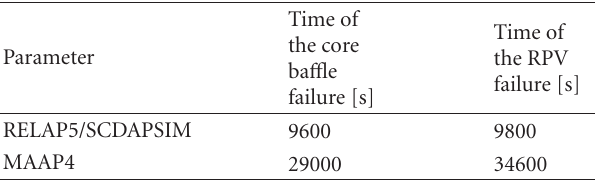
Table 5: Time of the core ba ffl e and the reactor vessel failure, Group 2.